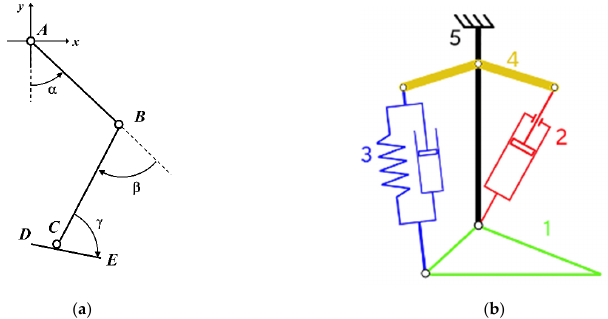
Figure 2. ( a ) The lower limb with the 3 angles and the mobile reference frame and, ( b ), the sketch of the ankle-foot prosthesis designed. About the components of the prosthesis: 1 is the foot; 2 is the linear actuator; 3 is the shock-absorber; 4 is the rocker arm; 5 is the prosthetic